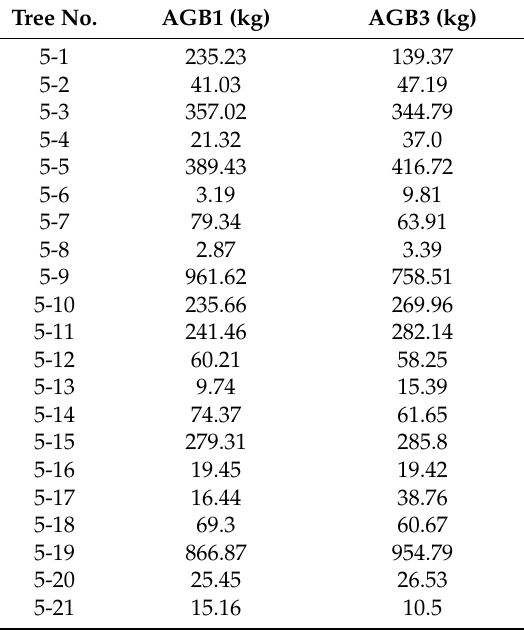
Table 3. The estimated AGBs of individual Minjiang fir trees in plot 5 with Formulas (1) and (3). Tree